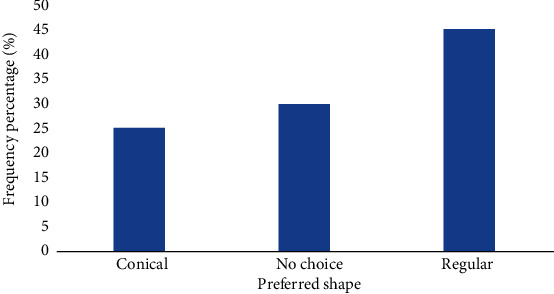
Preferred shape of mosquito bed net.